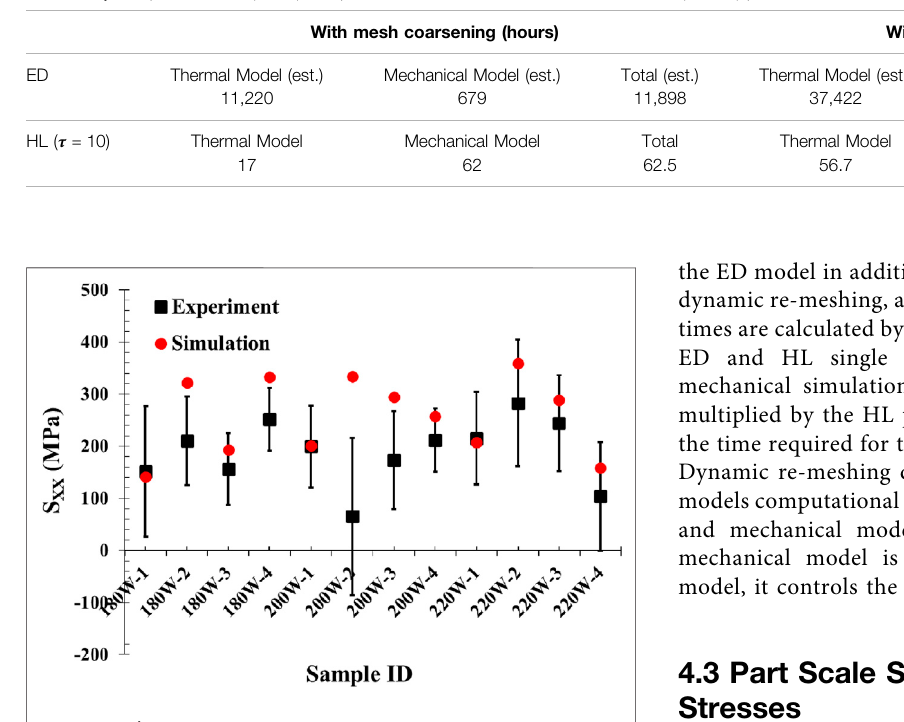
FIGURE 10 | Comparison between the measured and predicted residual stresses in the X -direction (S xx ) evaluated at the center of the specimens. For each specimen ID, the fi rst number refers to the laser power and the second number represents the scanning strategy given